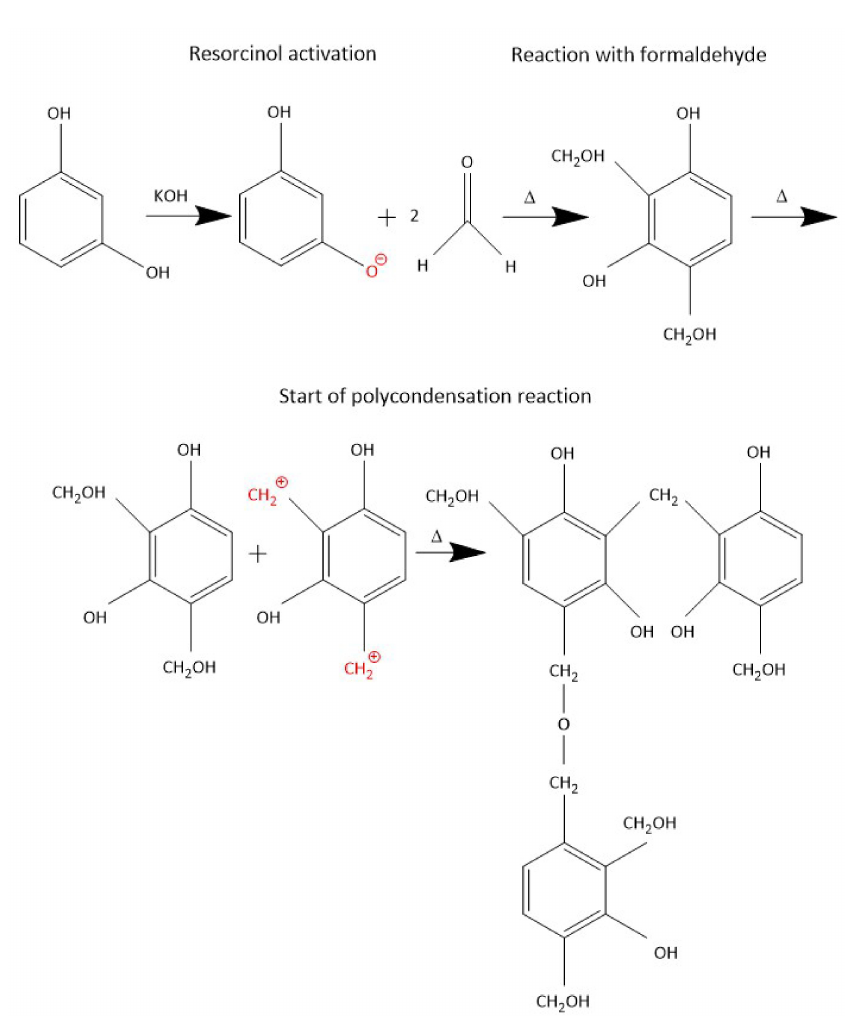
Figure 1. The schematic representation of resorcinol-formaldehyde oligomer synthesis ( ∆ is the heat of